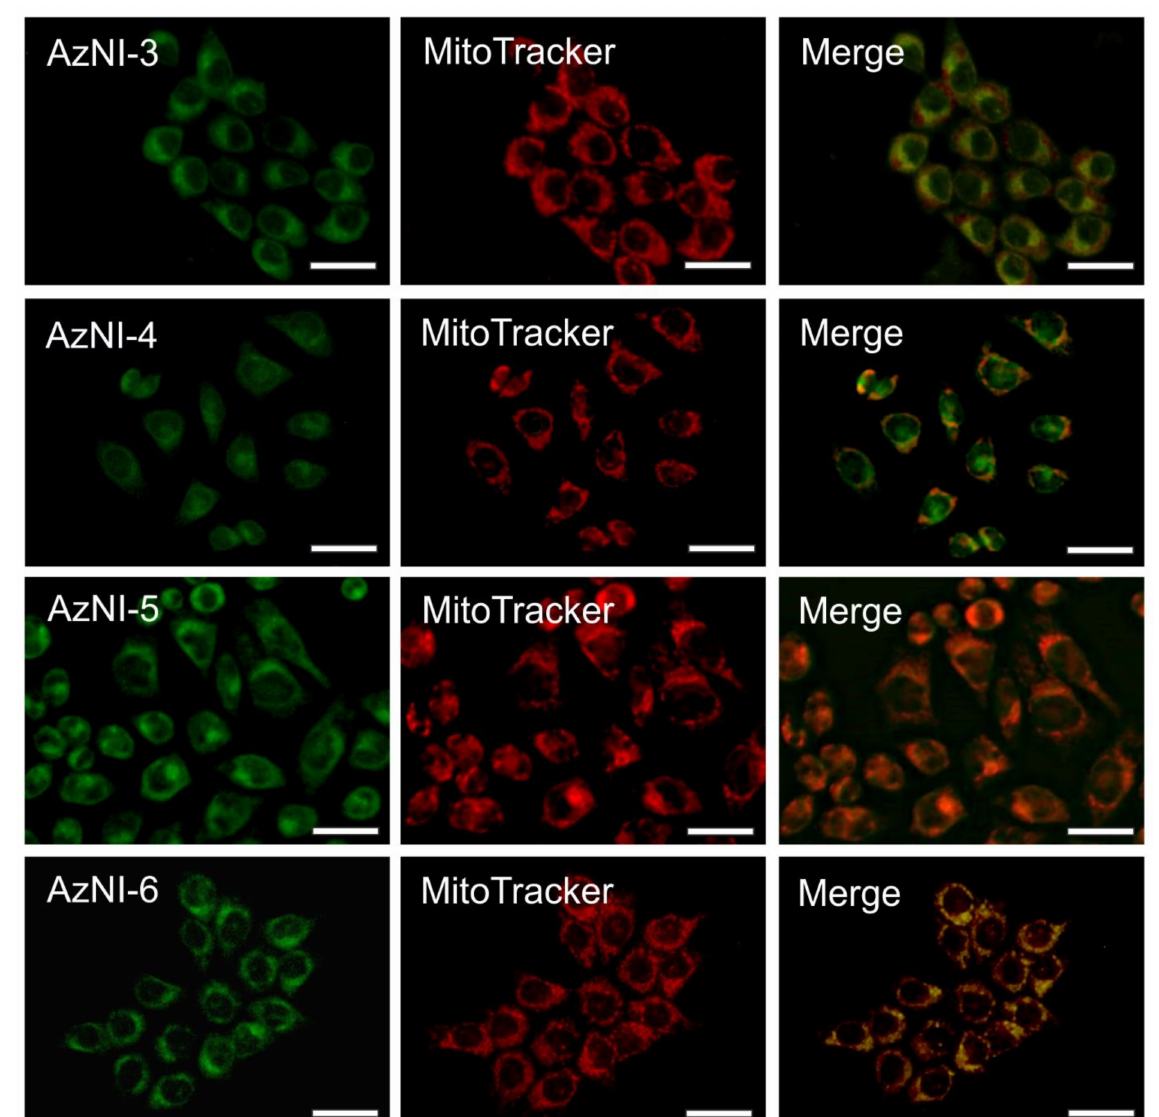
Figure 9. Co-localization fluorescence images of AzNI-3–6 at a concentration of 25 µ M and MitoTracker Orange dye in MCF-7 cells. The images acquired under 470 nm (for AzNIs) and 550 nm (for mitochondria-dye) LED illumination. Scale bars indicate 25 µ